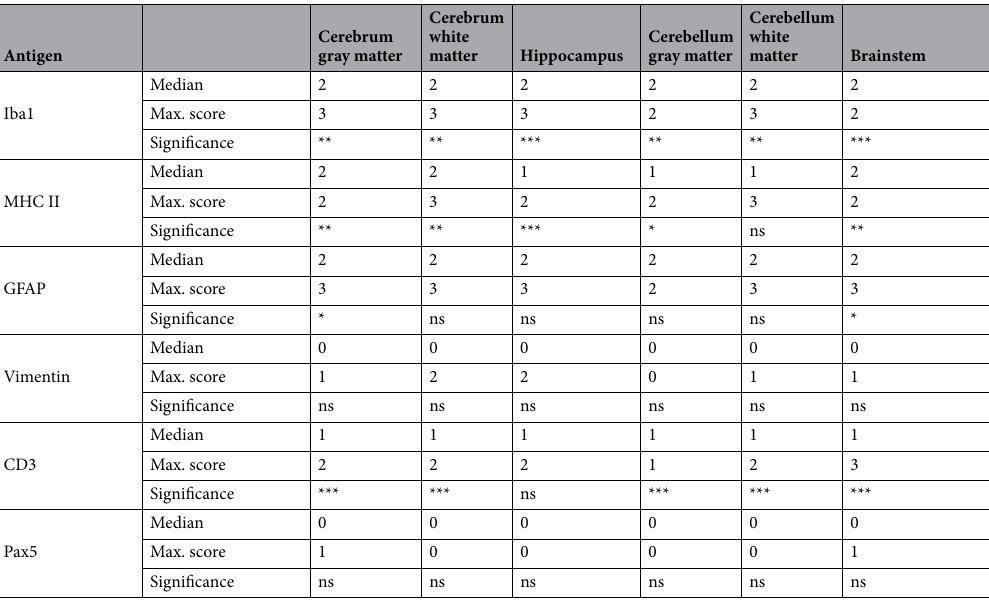
Table 3. Phenotyping of inflammatory responses in the brain of infected foxes. 0 = no observed immunoreactivity, 1 = single foci/cells, < 5%; 2 = multifocal reactivity, 5–30%; 3 = multifocal to diffuse reactivity, > 30%. Displayed in the table are median scores, and maximal scores observed in the respective areas, and the statistical significance levels as compared to uninfected control foxes. ns: not significant, * ≤ 0.05, ** ≤ 0.01, *** ≤